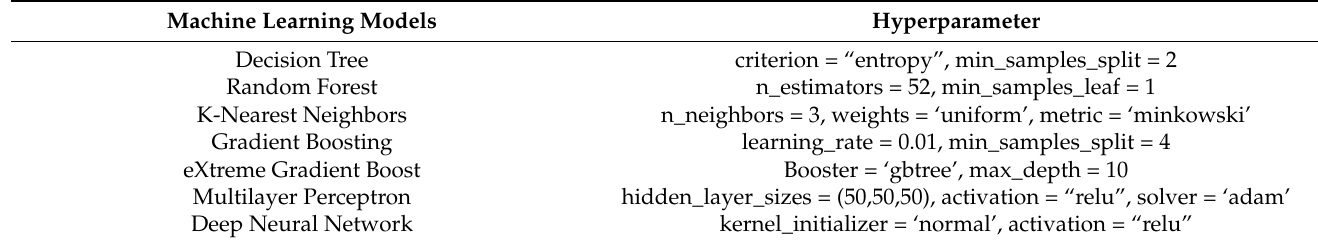
Table 2. Critical hyperparameters in machine learning